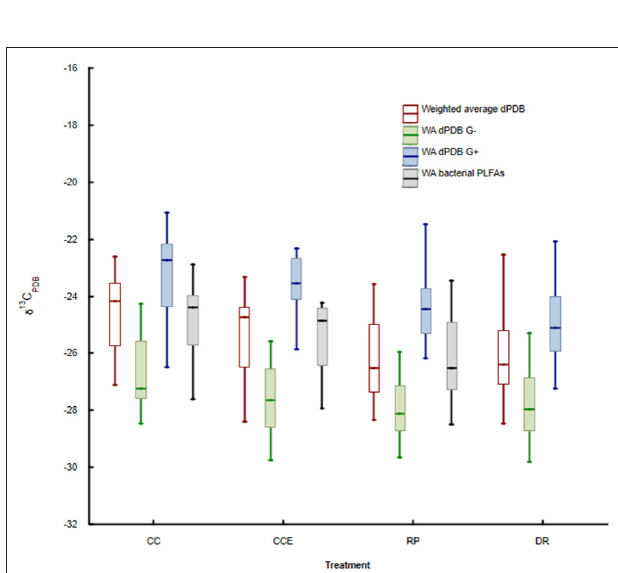
FIGURE 4 | Weighted average δ 13 C PDB of all analyzed PLFAs (red), the fungal biomarker PLFA 18:2 ω 6,9 (green), and bacterial Gram-negative (blue) and Gram-positive (black) biomarker PLFAs in the dispersed-retention (DR) treatment, the retention patch (RP), in the clear-cut treatment (CC, 9m, or more from the retention patch) and in the clear-cut edge treatment (CCE, within 9m of the retention patch).